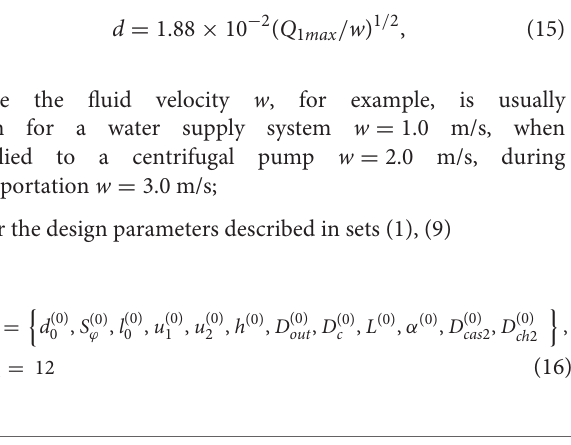
d 1.88 10 − 2 ( Q 1 max / w ) 1 / 2 = ×